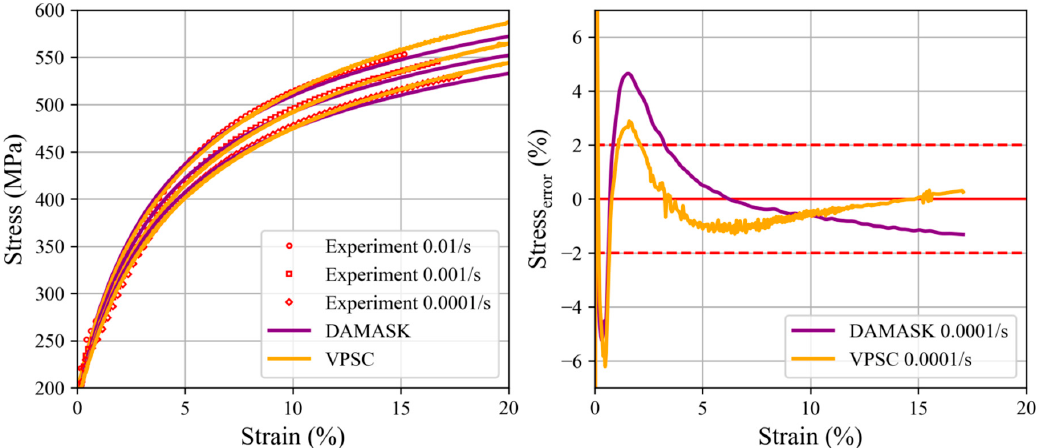
Figure 9. ( Left ) Experimental tensile test curves at different strain rates compared to simulated curves resulting during the calibration process using VPSC with GSODF full texture and Crystal Plasticity Finite Element Method (CPFEM) with RVE ODF20 . ( Right ) Strain dependence of the error of the predicted stress relative for the 0.0001 / s tensile curve (first, cubic spline interpolation was applied for 0 to 0.2 strain and 500 points).